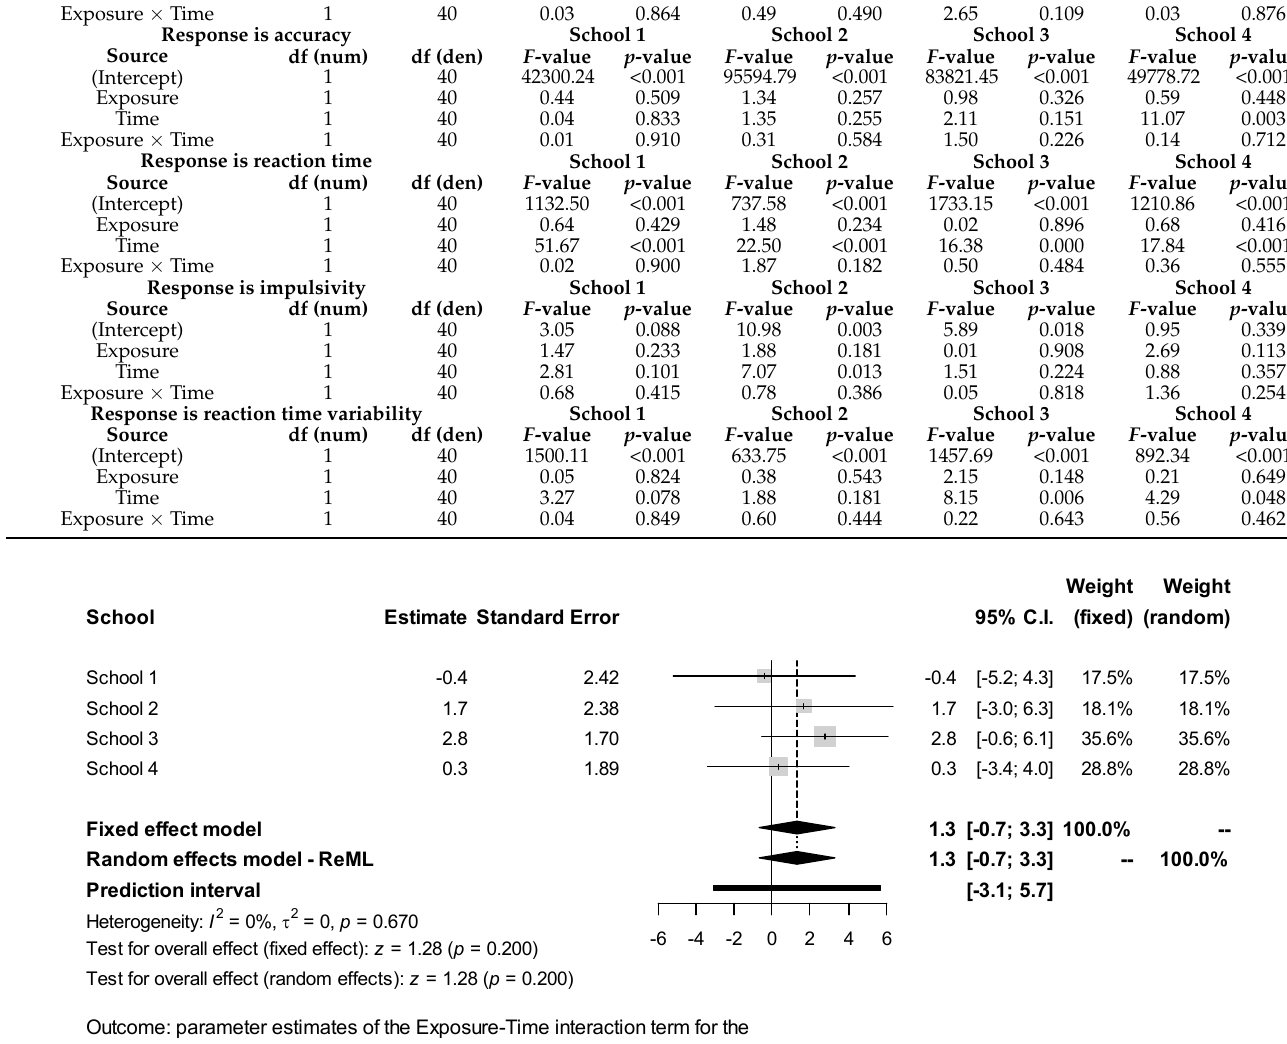
Figure 4. Meta ‐ analysis for test response reaction time.